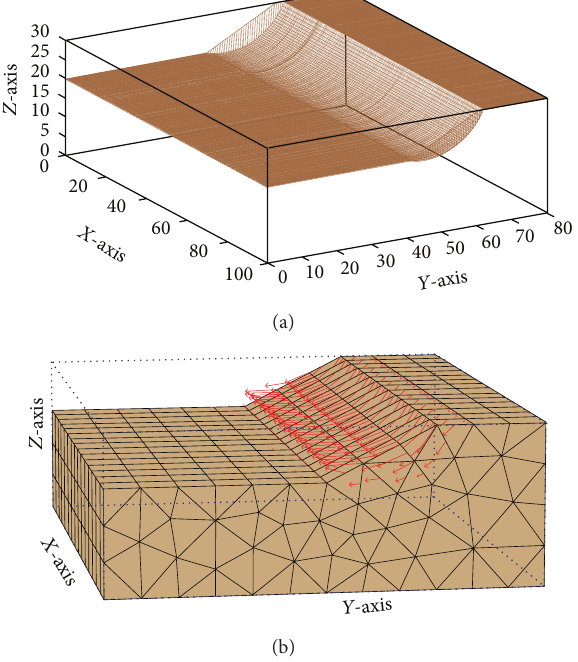
Figure 15: (a) The CSS obtained by the present study and (b) exag- gerated displacement vectors of PLAXIS-3D in example problem 1.